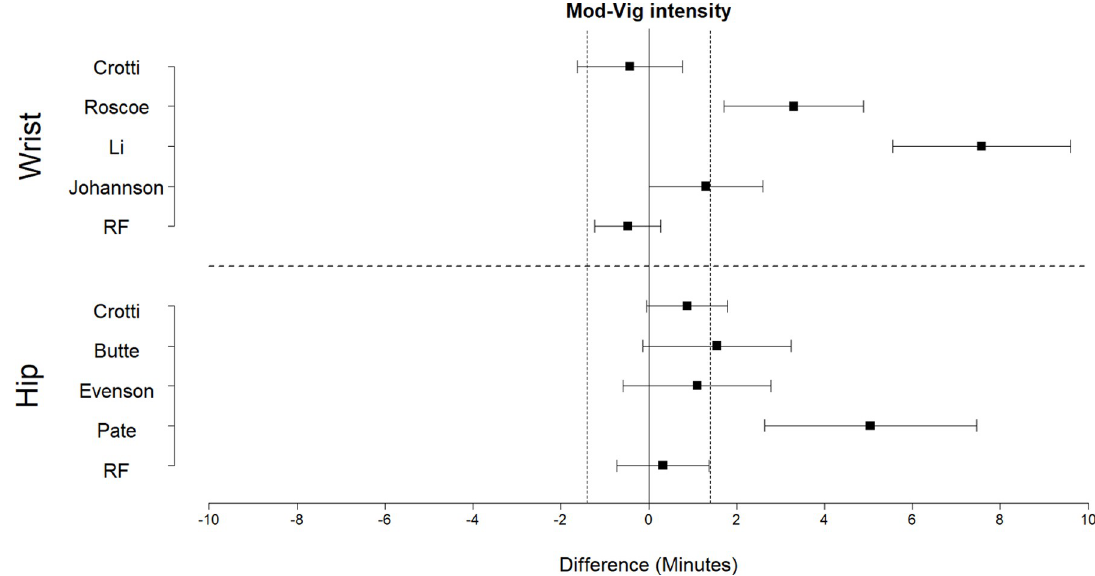
Fig 6. Equivalence plots for hip and wrist models for MVPA during the free play session. Difference = predicted time—observed time; Equivalence bounds = ± 1.4 min.